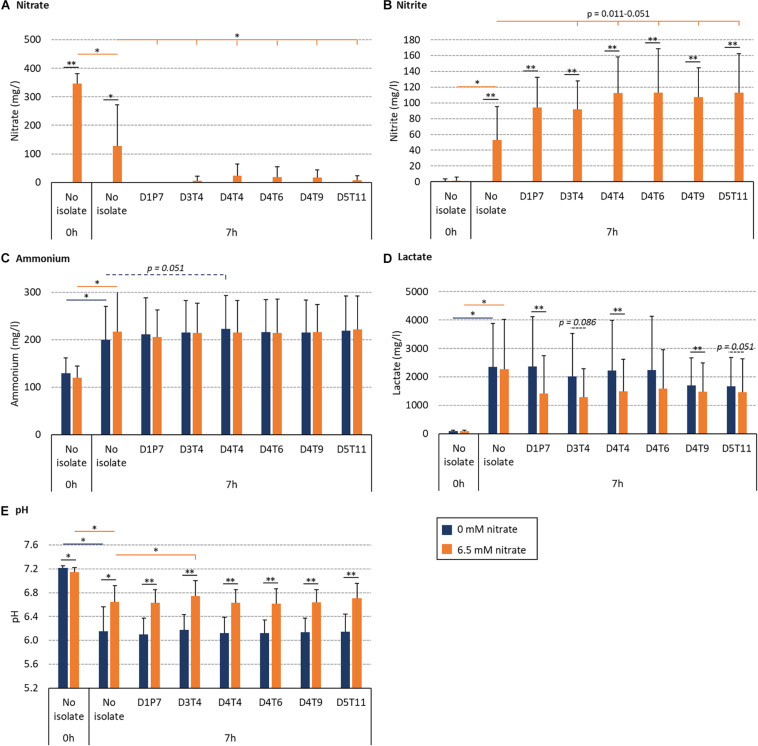
Effect of nitrate and six nitrate-reducing isolates on oral microcosm community metabolism. Bar plots show averages and standard deviations of supernatant measurements. Saliva of 9 donors was incubated with nutrient-rich medium to form in vitro oral biofilm with 6.5 mM nitrate (orange) or without nitrate (blue). Values correspond to measurements before incubation (0 h, which is the initial mixture of saliva and medium) and after 7 h of incubation. (A) Nitrate (mg/l), (B) nitrite (mg/l), (C) ammonium (mg/l), (D) lactate (mg/l), and (E) pH. All conditions with and without nitrate were compared (black lines with p-values). Additionally, conditions with isolates (D3T4, D4T4, D4T6, D4T9, and D5T11) were compared with the conditions without an isolate (i.e., no isolate): dark blue lines with p-values compare 0 mM nitrate conditions and orange lines with p-values compare 6.5 mM nitrate conditions. ∗p < 0.05, ∗∗p < 0.01 according to a Wilcoxon test.